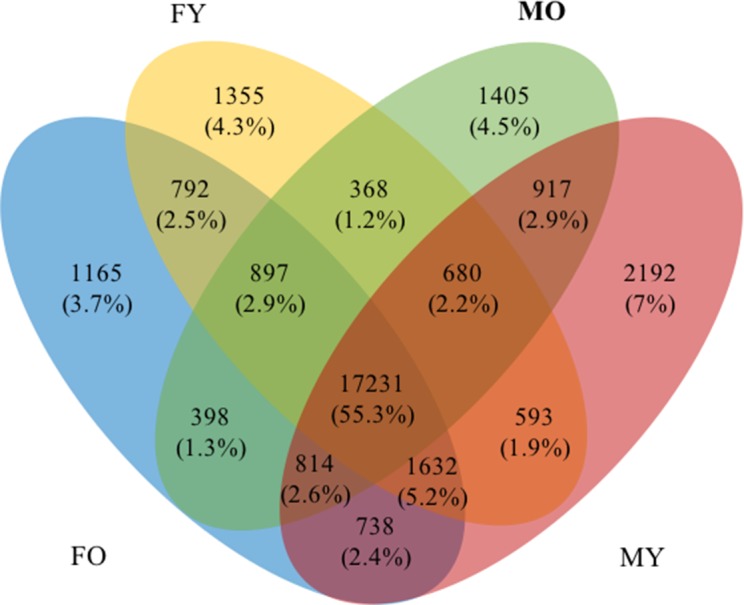
A Venn diagram of four transcript datasets.Numbers and percentages of transcripts are indicated.